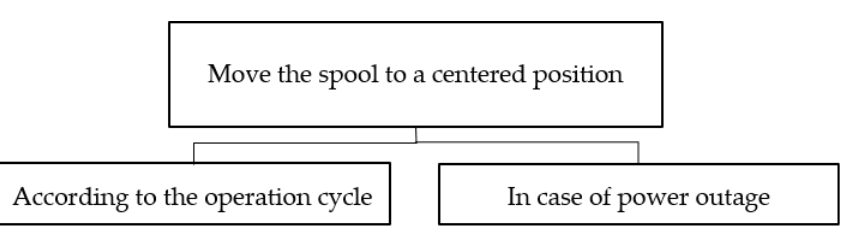
Figure 9. The divided general function of the springs.